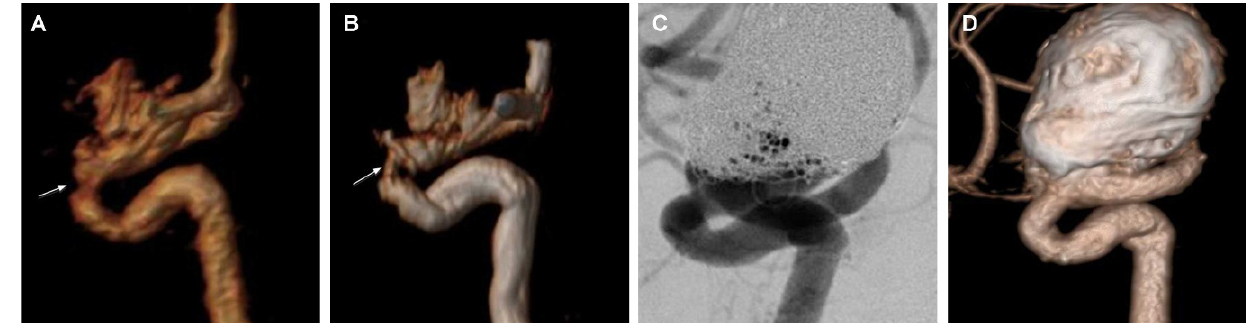
Figure 4 - Follow-up of an aneurysm treated with a stent remodeling technique (Neuroform 3), assessing the patency of the parent artery within the stent. A, B: CE-MRA and TOF-MRA, respectively, with volume-rendered reconstruction showing a focused loss of signal, simulating an in-stent stenosis. C, D: DSA and DSA with 3D reconstruction showing a normal parent artery patency within the